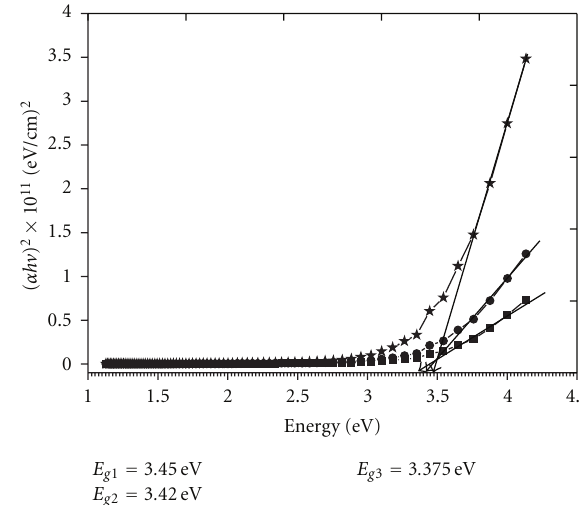
Figure 4: Transmission spectra of ZnO thin films of varying thick- nesses.